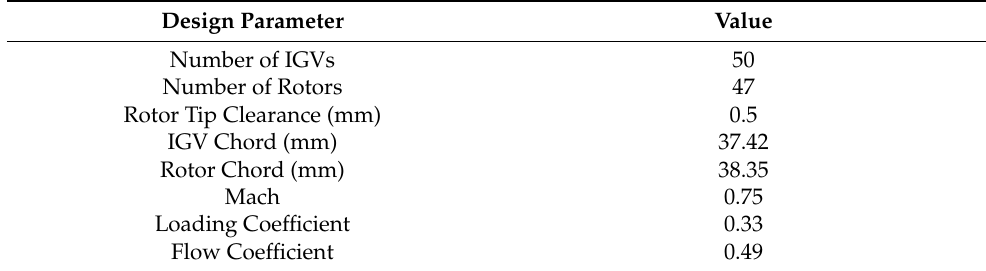
Figure 1. The physical model of the compressor used in this study. Table 1. Main parameters of the compressor used in this study.